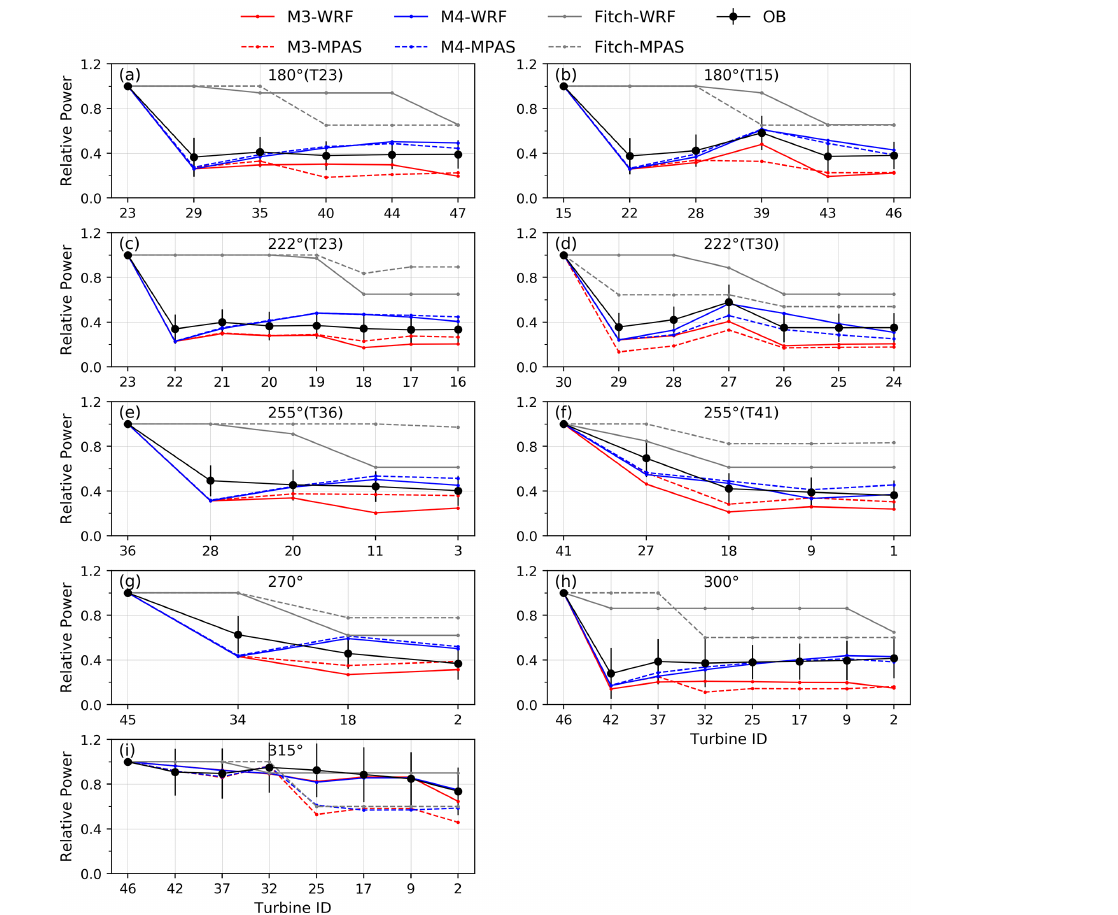
Figure 6. Same as Fig. 4 but for Lillgrund multi-cell cases with (cid:49)x = 2km.